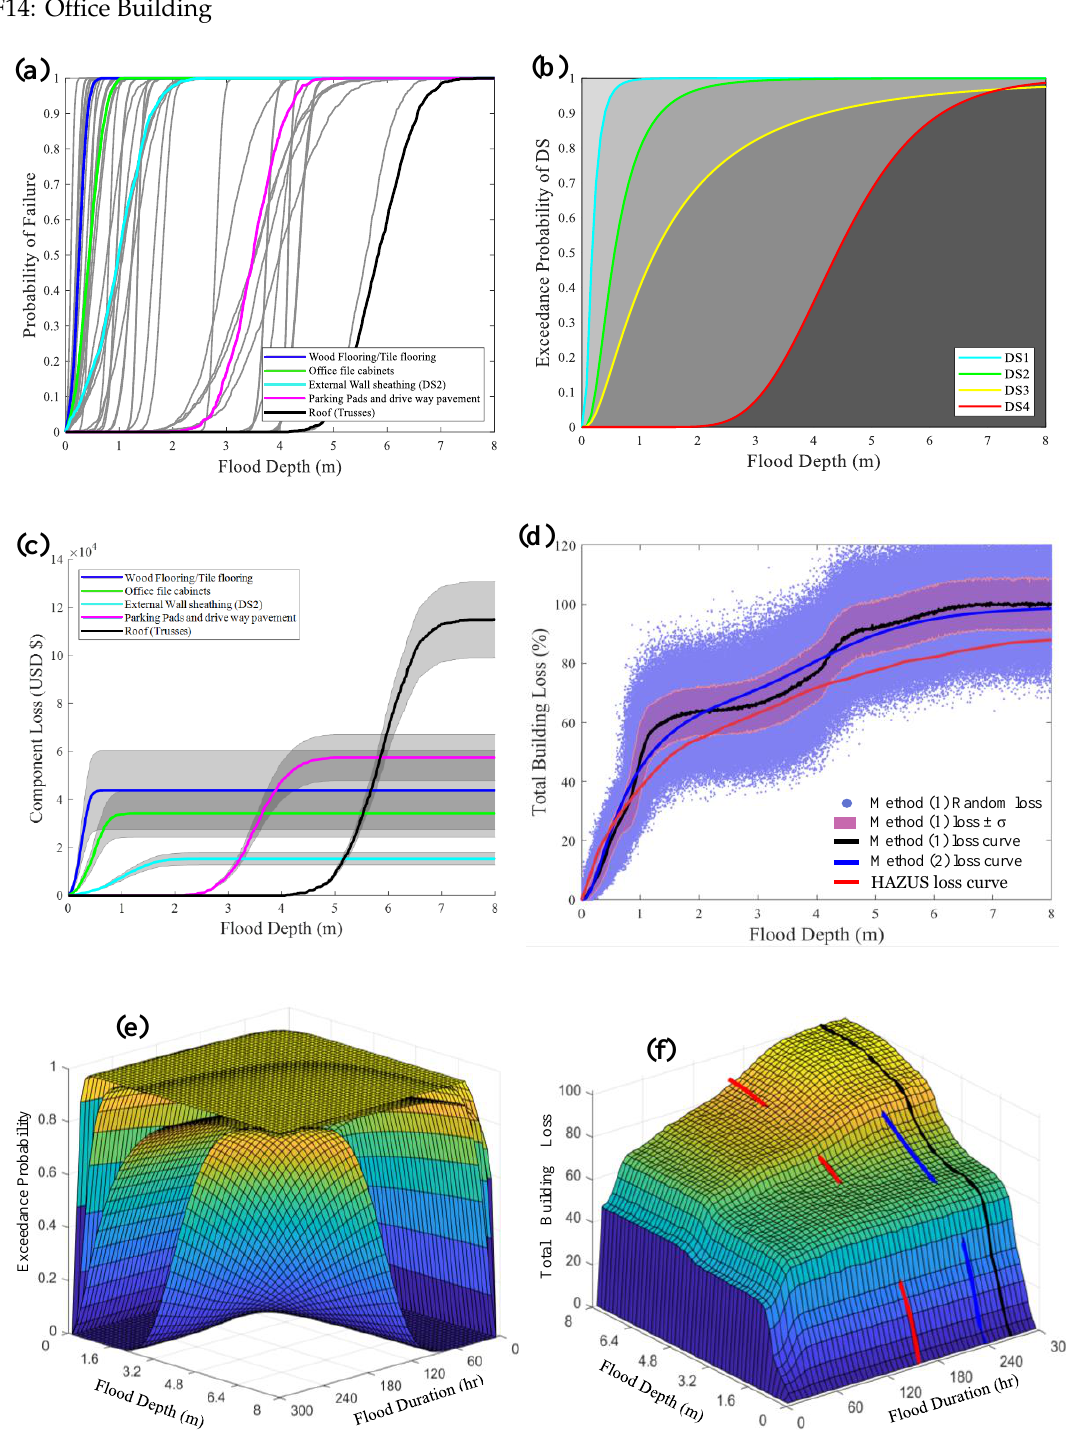
Figure A28. F14 archetype analysis results: ( a ) Component fragility curves; ( b ) Building fragility curves; ( c ) Selected components’ loss curves; ( d ) Building loss curves; ( e ) Building fragility surfaces; ( f ) Building loss surface.